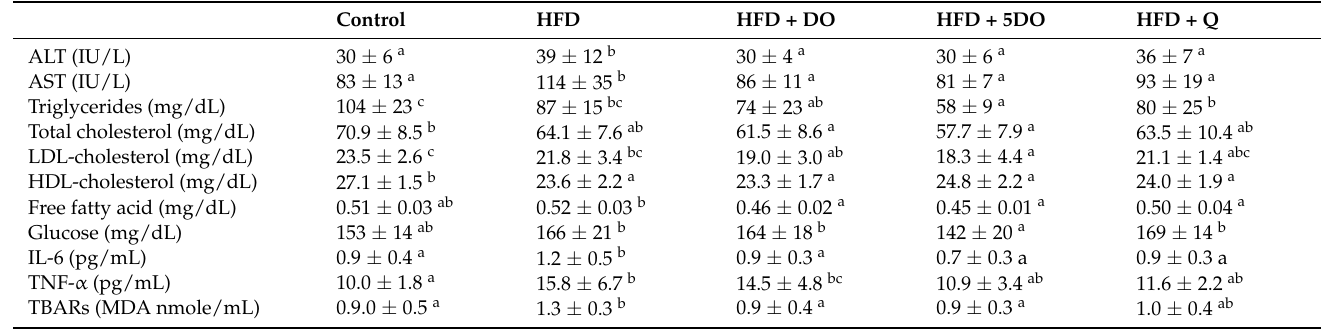
Table 3. Effects of dried onion powder and quercetin on the blood biochemistry values, pro- inflammatory cytokines and TBARs in Sprague Dawley rats exposed to HFD 1 .